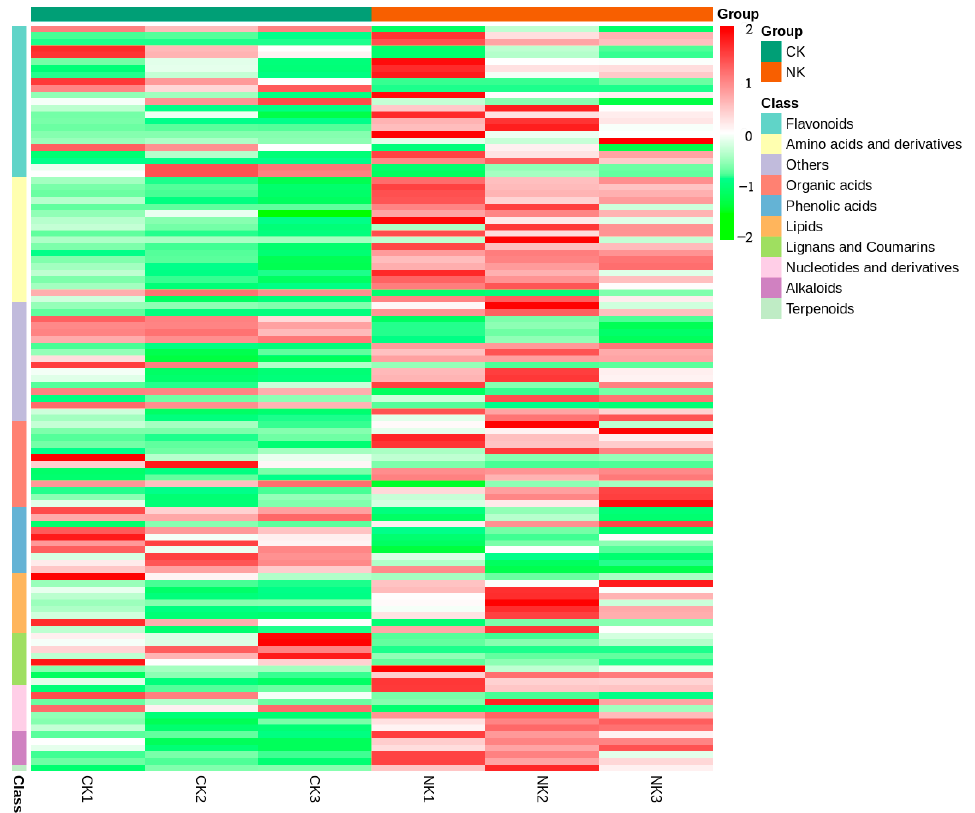
Figure 3. Differential metabolite clustering heat map of water dropwort under soil culture (CK) and Yamasaki nutrient solution (NK).